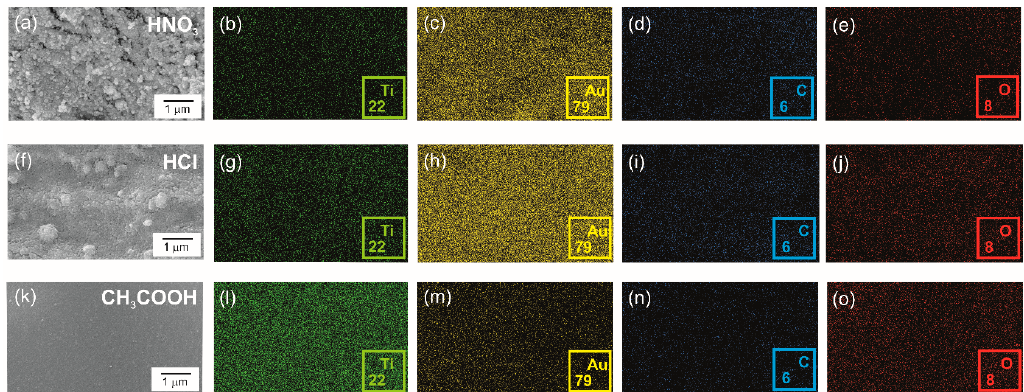
Figure 3. SEM images of the TiO 2 nanostructured films produced using nitric acid ( a ), hydrochloric acid ( f ) and acetic acid ( k ) together with their corresponding energy dispersive spectroscopy (EDS) maps of Ti, ( b , g , l ), Au ( c , h , m ), C ( d , I , n ) and O ( e , j , o ).